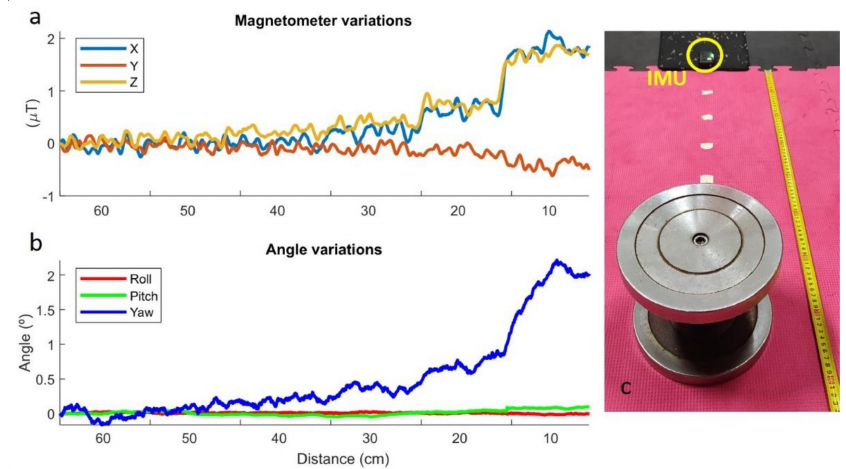
Figure 4. Static perturbations. ( a ): Magnetometer variations; ( b ): Angle variations; ( c ) Experimental measurements.